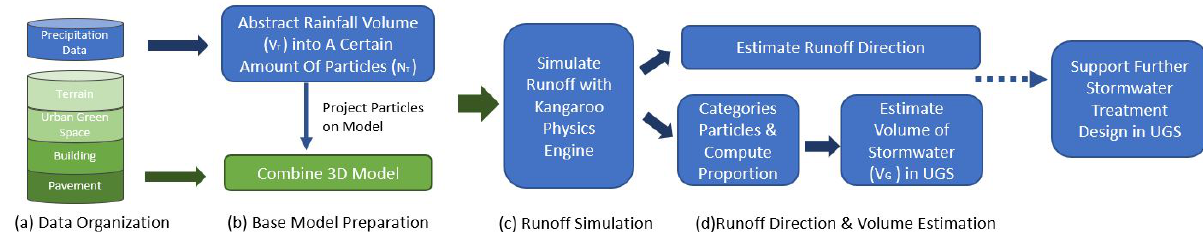
Figure 2. Research Framework Diagram